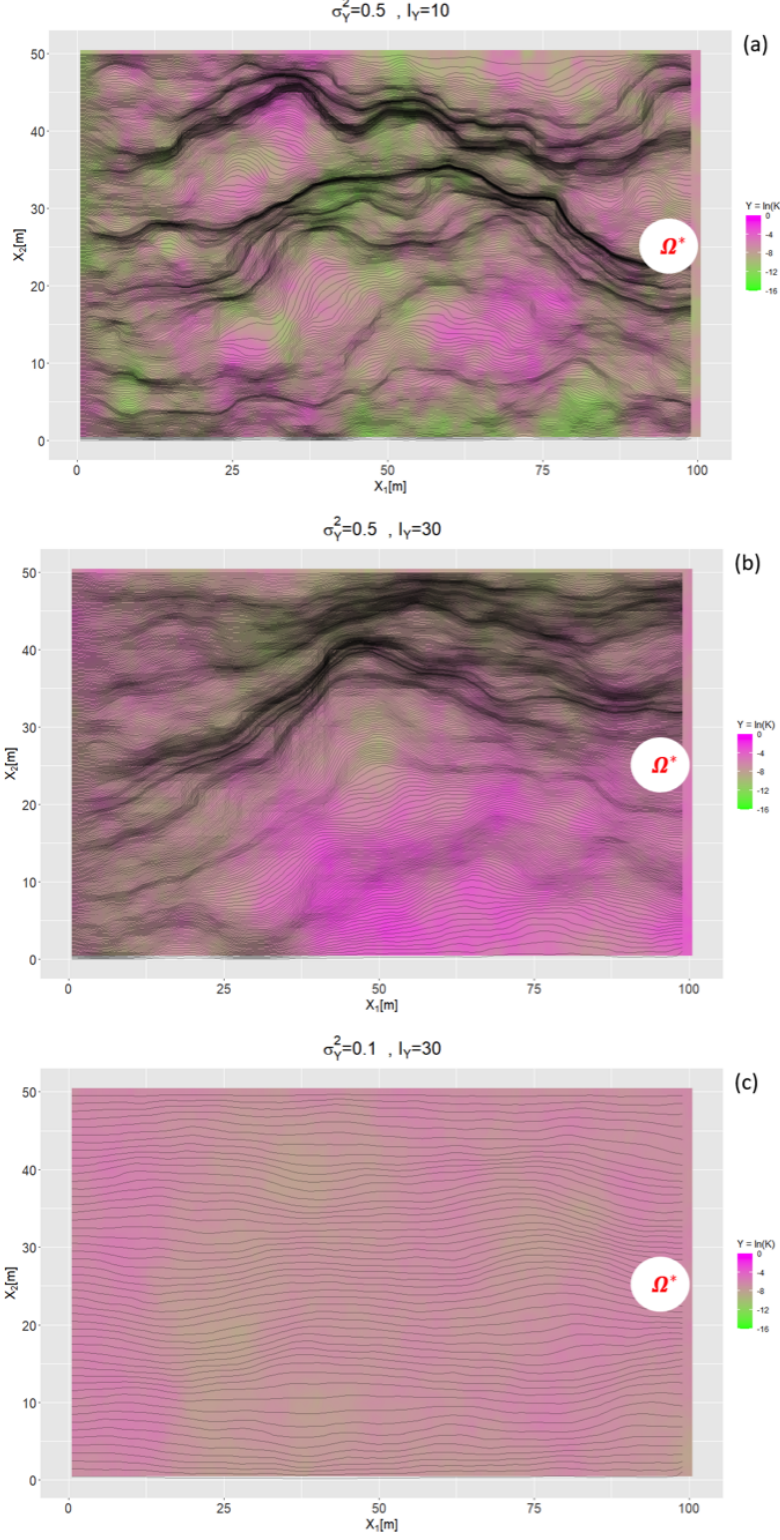
Figure 2. Illustrative example of a heterogeneous log-hydraulic conductivity field and solute particle transport. Black lines represent simu- lated particle travel paths. A left to right hydraulic gradient of 0.1 is applied. Mean of log conductivity is set at − 3. Note that color scales for log conductivity are consistent in all three